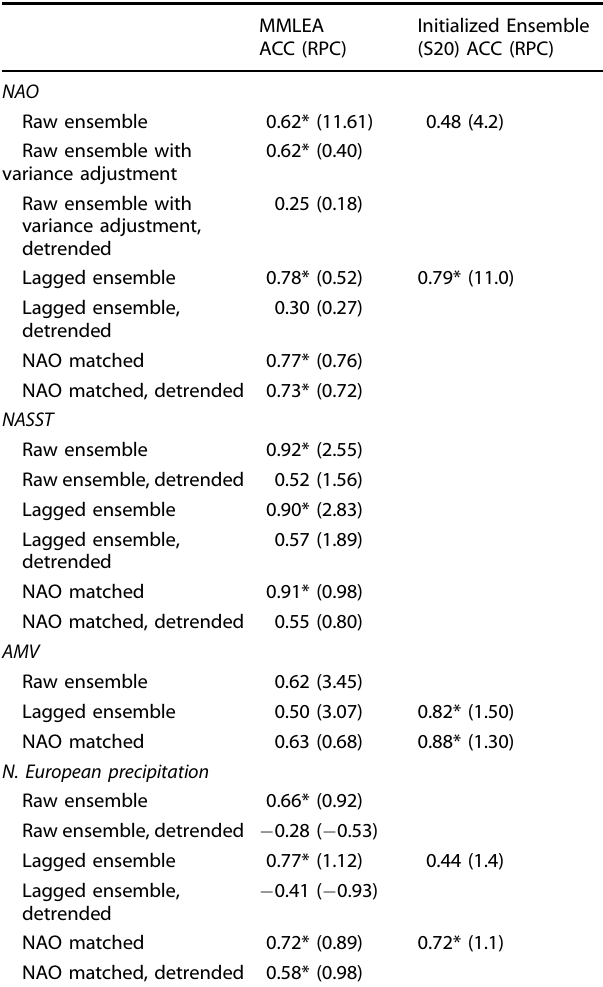
Table 1. Comparison of the results presented in this paper to S20 ’ s